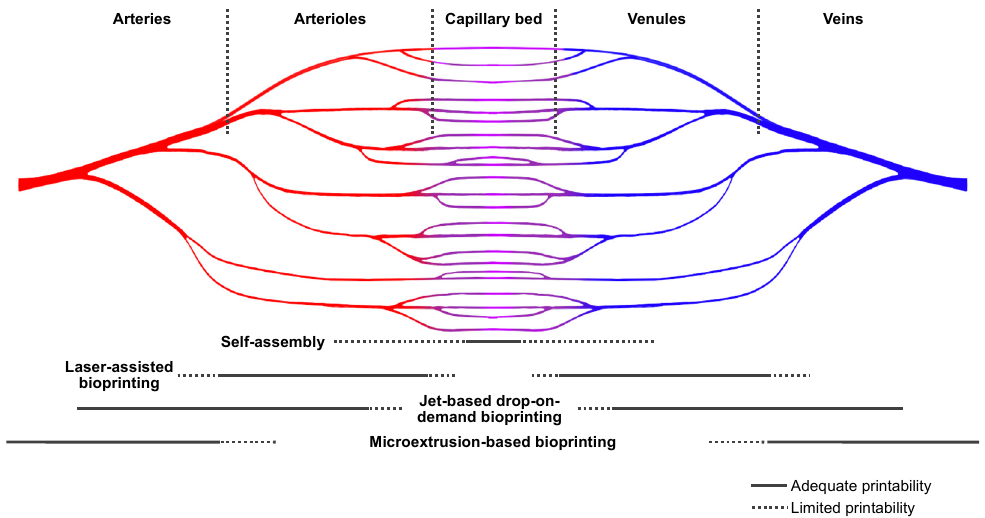
Figure 4. Bioprinting technologies categorized regarding their applicability for fabrication of macro- or microvascularization. Limited printability can be due to lack of resolution, low printing precision, and/or a long duration of the printing procedure. Small-scale capillaries cannot yet be fabricated by 3D-bioprinting technologies and are subject to self-assembly strategies.